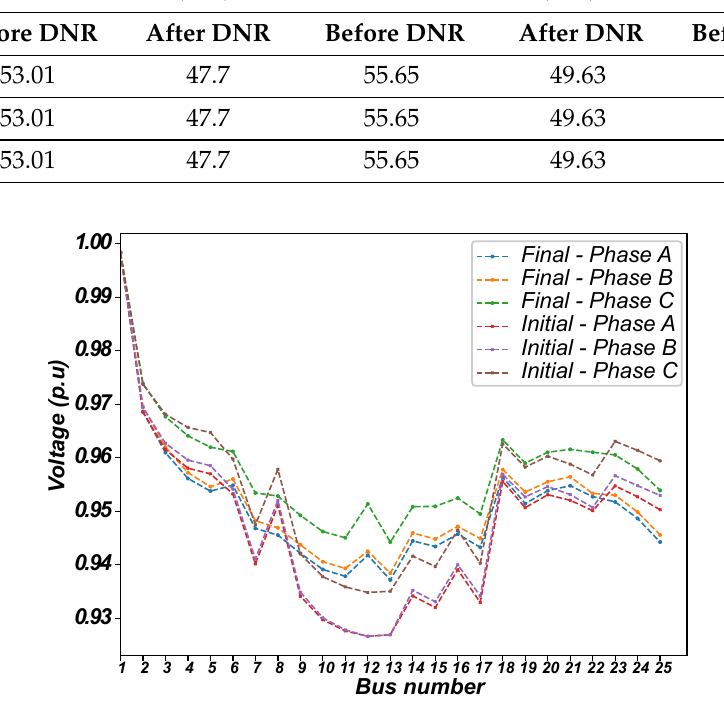
Figure 13. 25-bus and 27-branch system voltage levels